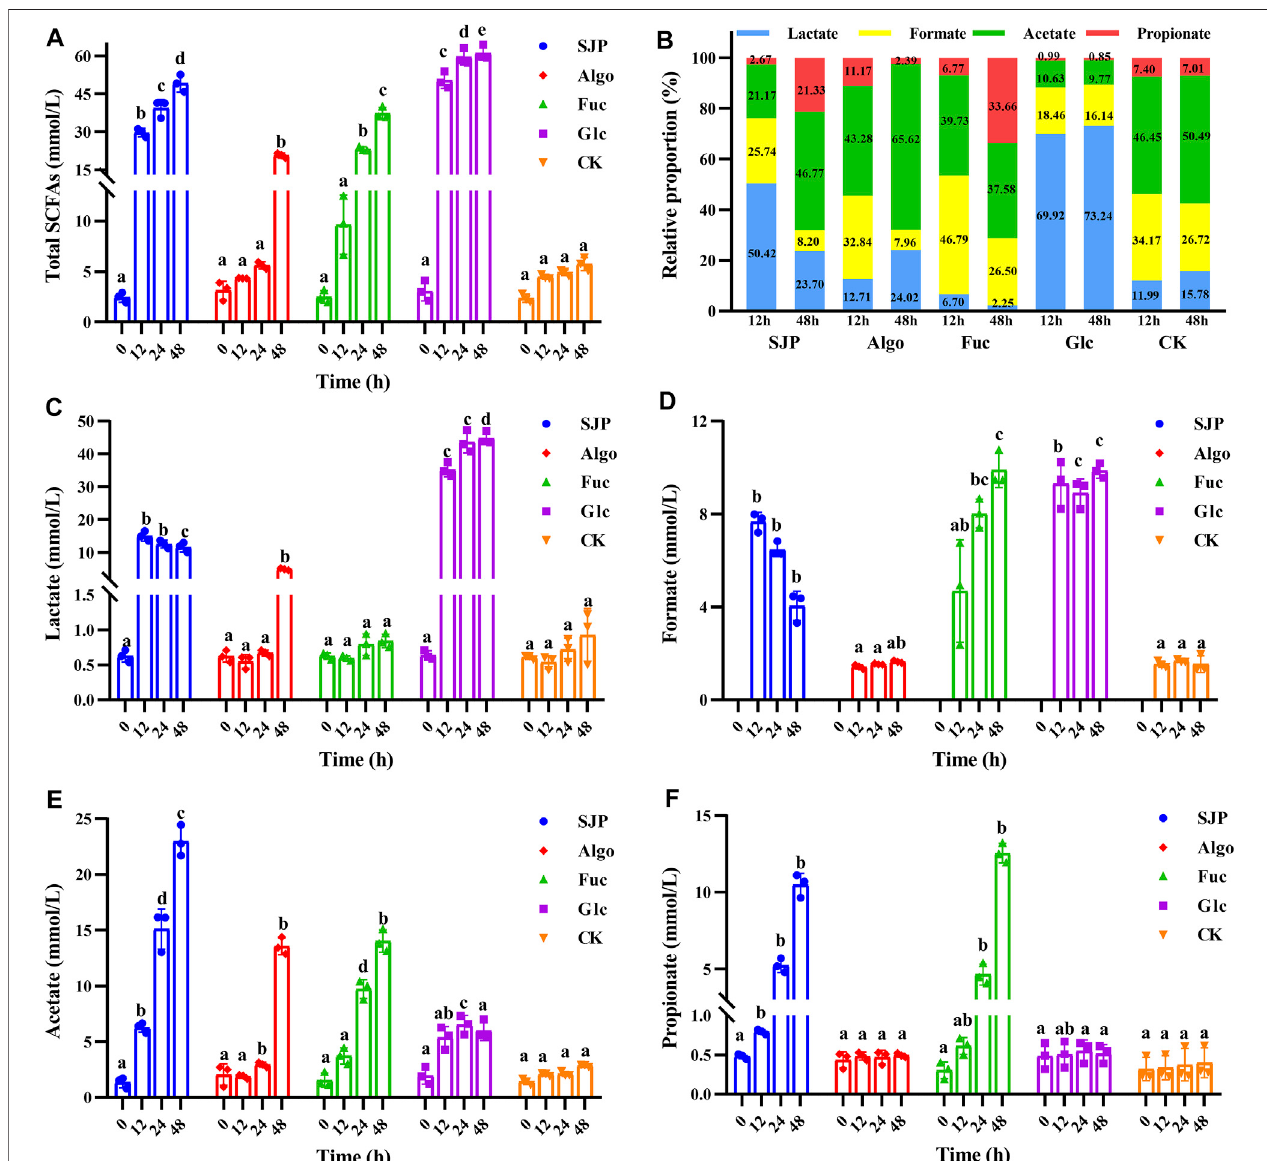
FIGURE 4 | SCFA production during the in vitro degradation of SJP, alginate oligosaccharides (Algo), fucose (Fuc), and glucose (Glc). The control condition (CK) wasachievedbyexcludingtheadditionofexperimentalsubstances.Theconcentrationsof (A) totalSCFAs, (C) lactate, (D) formate, (E) acetate,and (F) propionatewere determined at 0, 12, 24, and 48 h, respectively. (B) Relative proportion of individual SCFAs at 12 and 48 h. Results are shown as mean ± SD ( n (cid:2) 3). a,b,c,d Signi fi cant differences were analyzed using Kruskal – Wallis with Games – Howell test for multiple groups comparisons at the same fermentation time ( p < 0.05). SCFA, short- chain fatty acid; SJP, seaweed Laminaria japonica